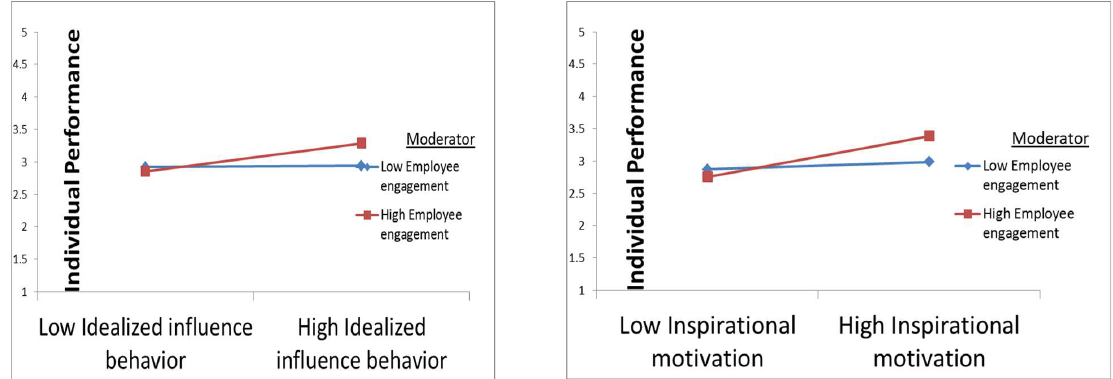
Fig. 2 . Moderate of employee